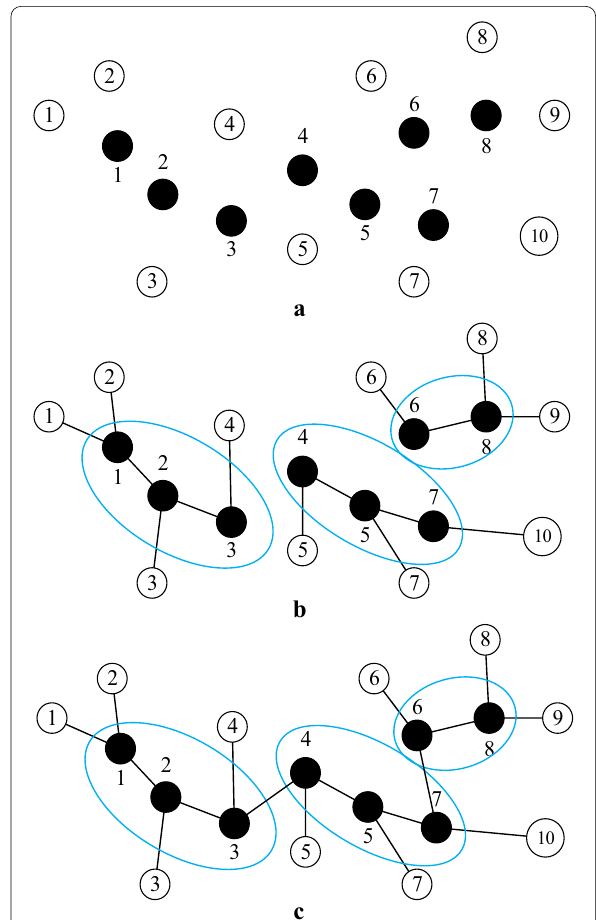
Figure 6 Process of the population initialization: a Randomly generate the branch points; b Divide the branch points into [ N / K ] sets; c Randomly choose one point of sets to be